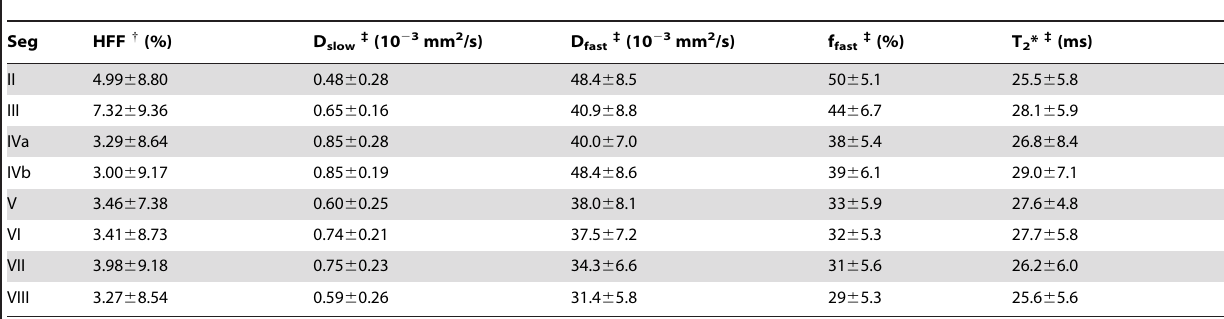
Table 3. Hepatic fat fraction (HFF), IVIM-DWI parameters and T 2 * per segment.